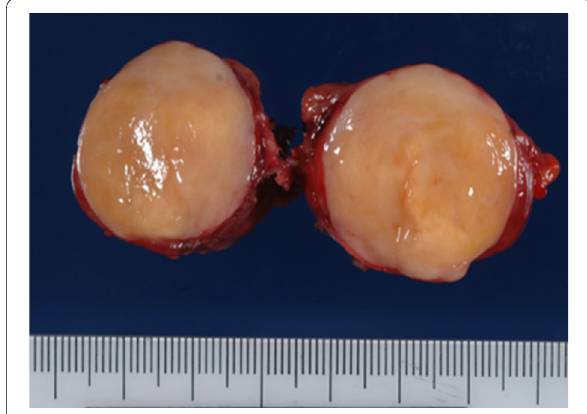
Fig. 5 Macroscopic findings. The elastic, hard tumor measured 40 30 mm and had a smooth surface and fibrous capsule. The × cross-section was milky white in color